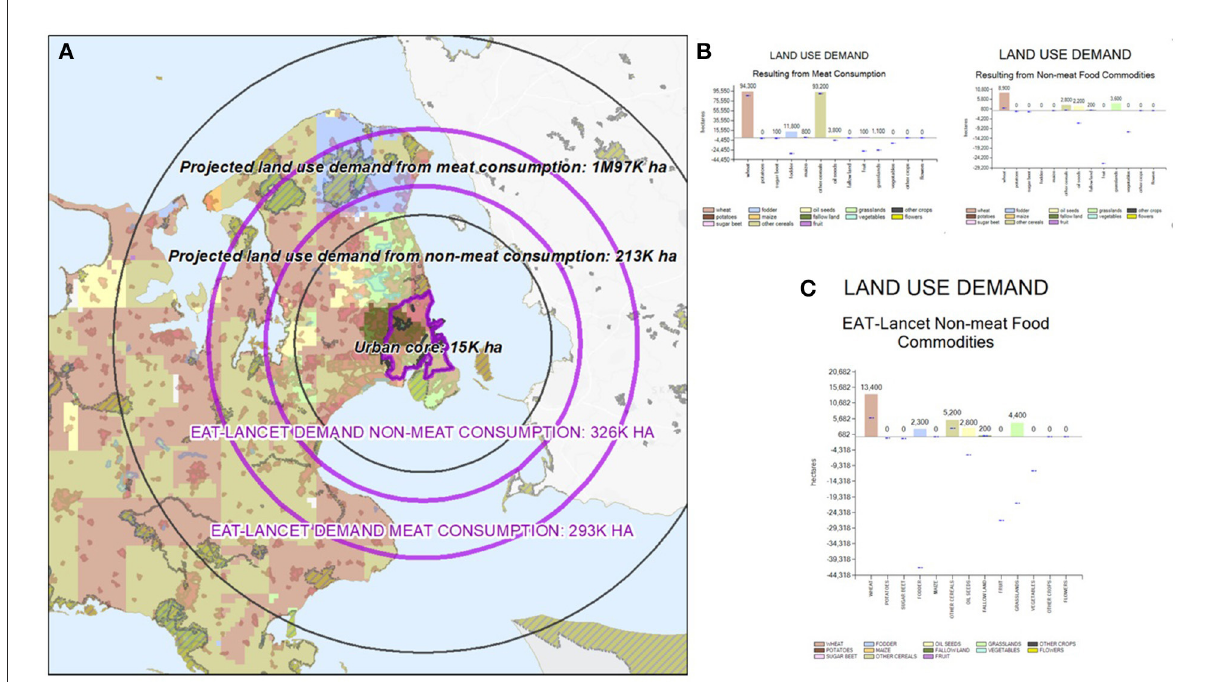
FIGURE7 Land footprints of status quo and EAT-Lancet diet scenario: (A) overlaid with map of food groups. (B) Charts showing aggregated food group supply values in hectares within each ring for the status quo. (C) Chart showing aggregated food group supply values in hectares within the plant-based ring for the EAT-Lancet scenario.